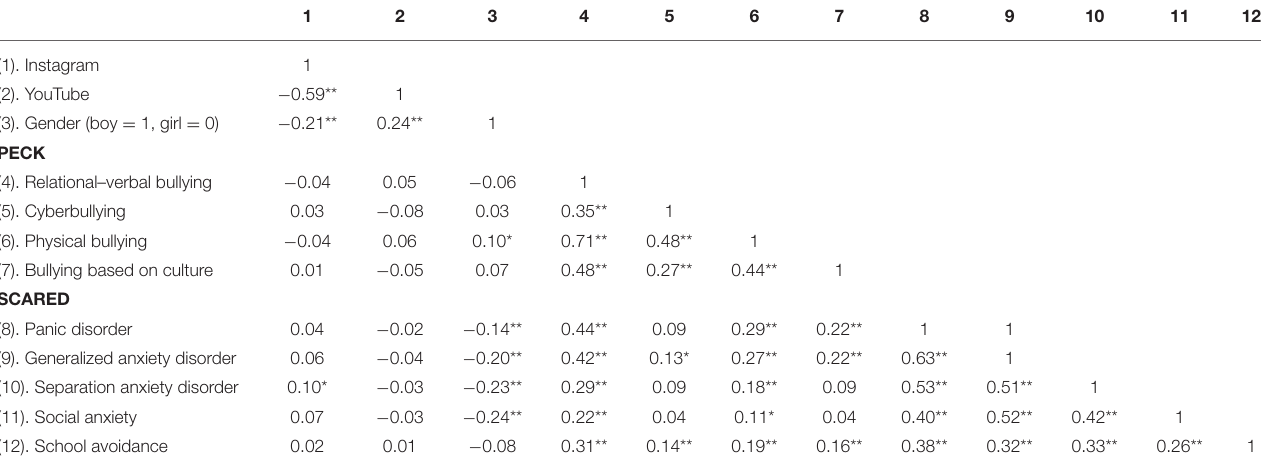
TABLE 4 | Correlation matrix of social media types, gender, bullying victimization, and anxiety ( N = 456).